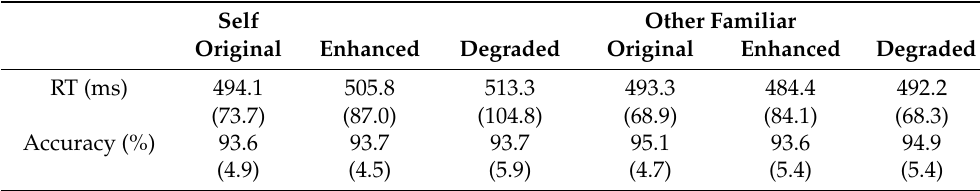
Table 1. Mean and standard deviation of RT and accuracy rate in each condition. Standard deviations are in